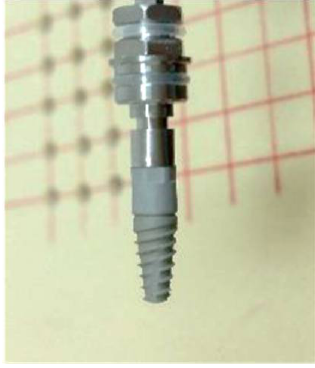
Figure 1. A novel non-screw-type removable collar implant design.